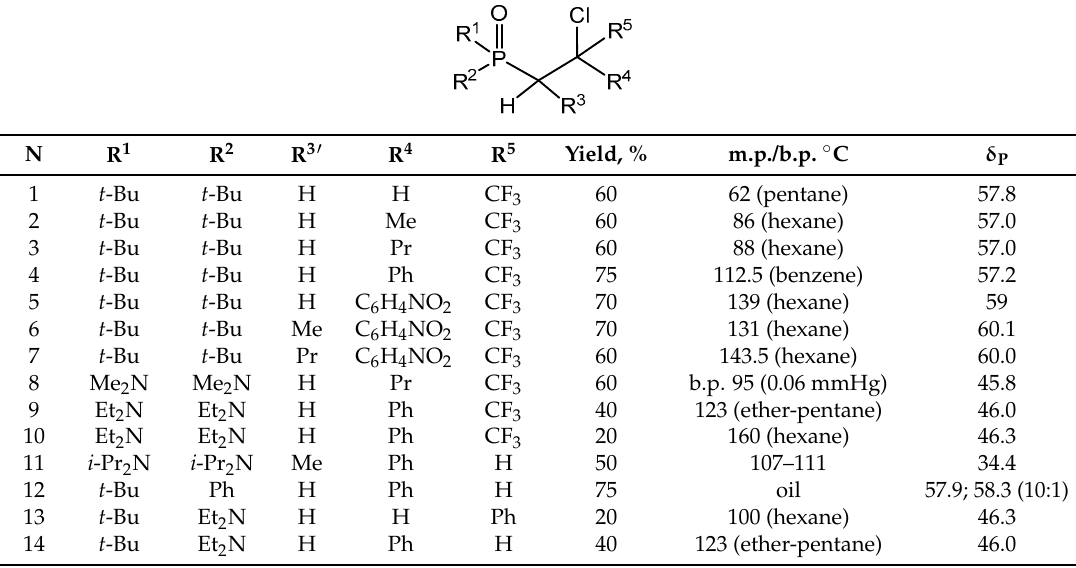
Table 4. Effect of solvent on δ P of 2-chloro and 2-bromo-1,2 λ 5 -oxaphosphetanes.